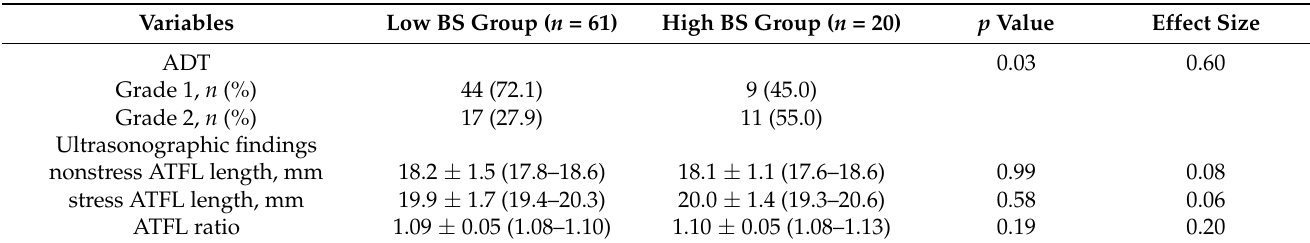
Table 2. Results of ADT and ultrasonographic